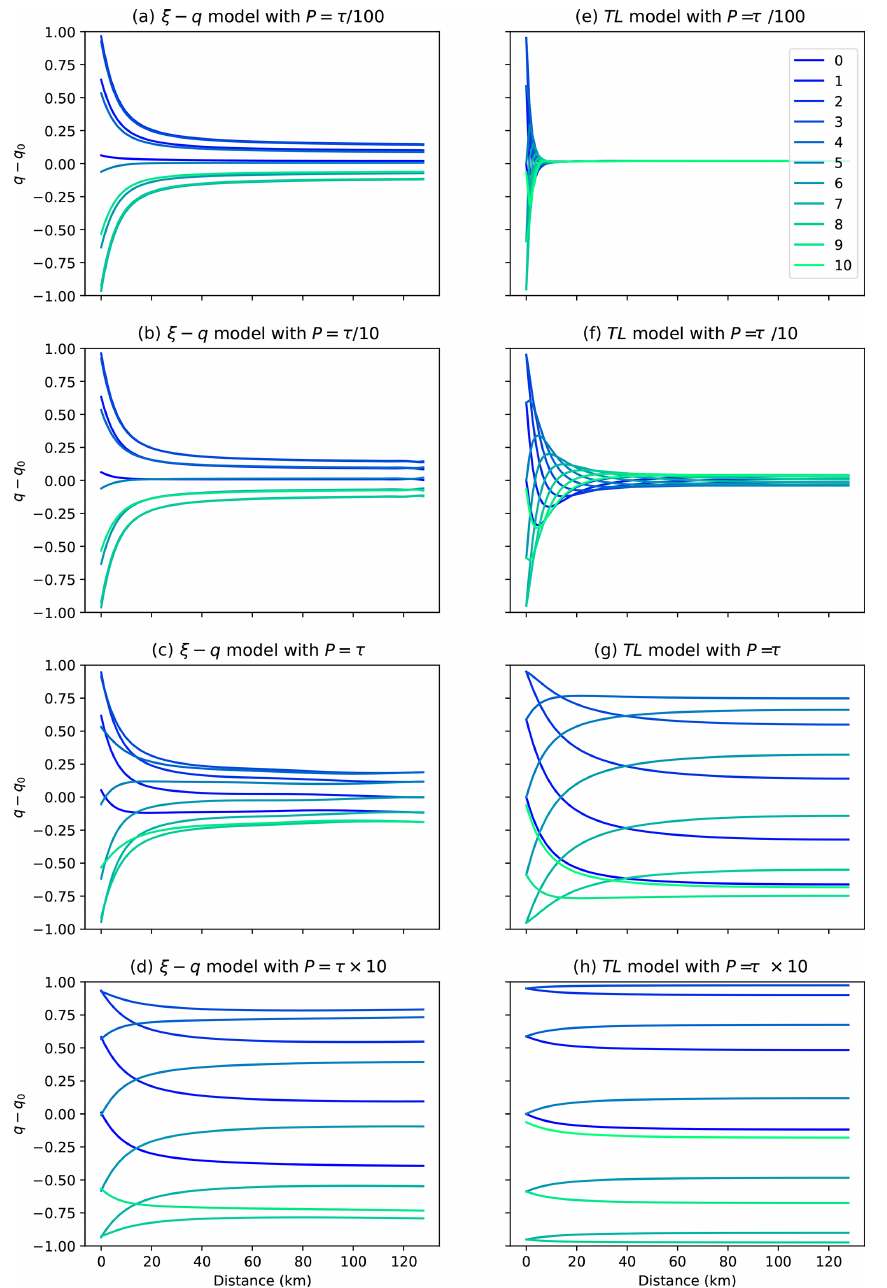
Figure 12. Computed flux profiles across the sedimentary system at 10 time steps within one of the imposed incoming flux cycles (a– d) using the ξ – q model and (e–h) using the TL model. Going from top to bottom, the forcing period is equal to τ/ 100, τ/ 10, τ , and 10 × τ , respectively. In all cases shown, L = 10 L 0